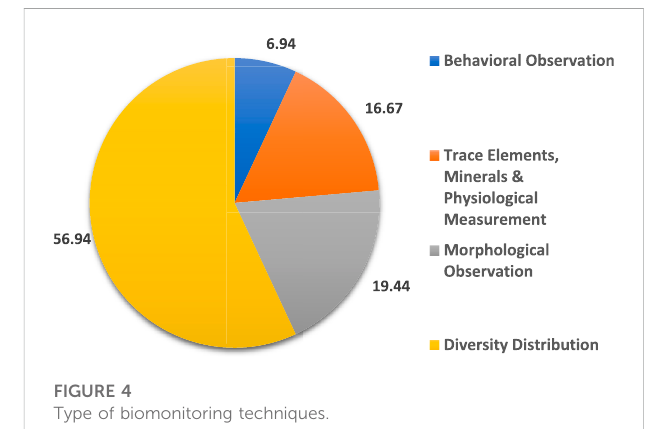
FIGURE 4 Type of biomonitoring